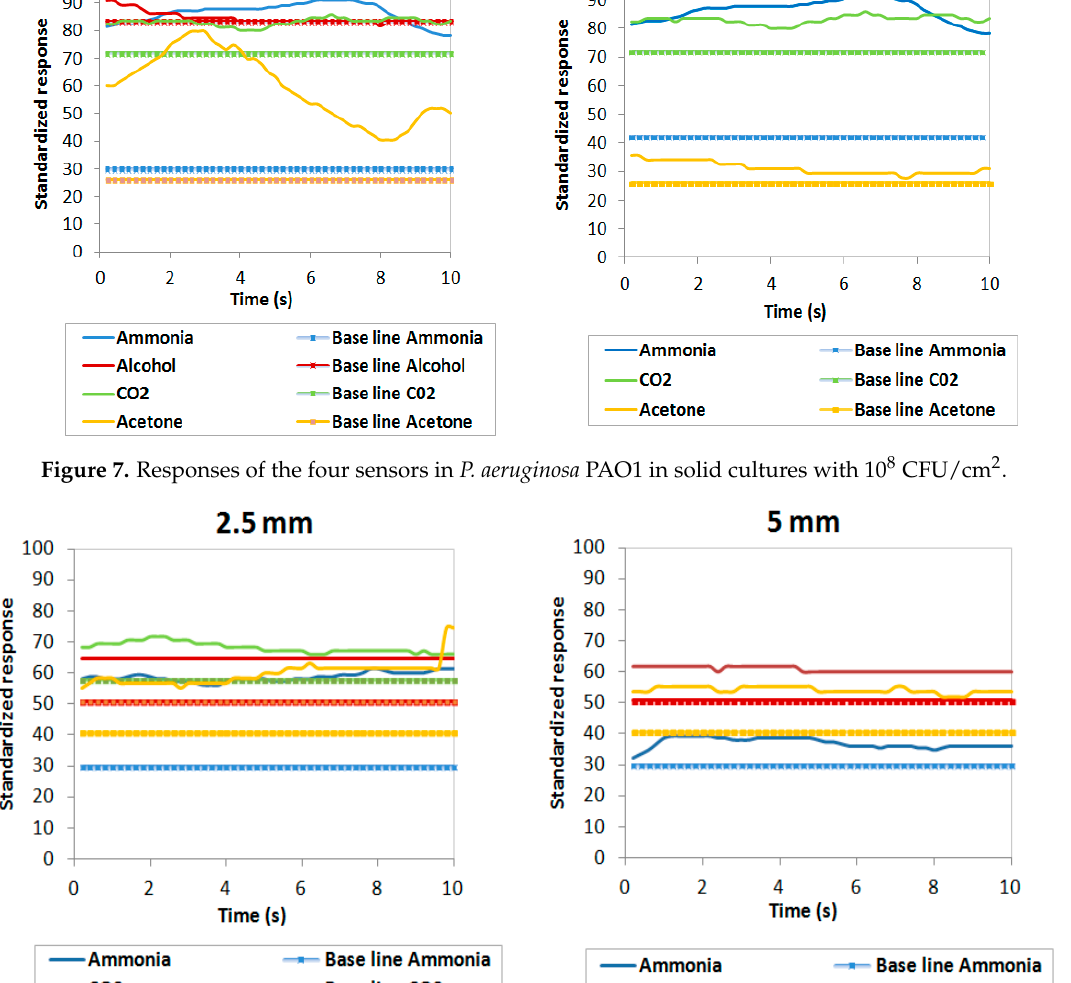
Figure 8. Responses of the four sensors in P. aeruginosa PAO1 in liquid cultures with 10 8